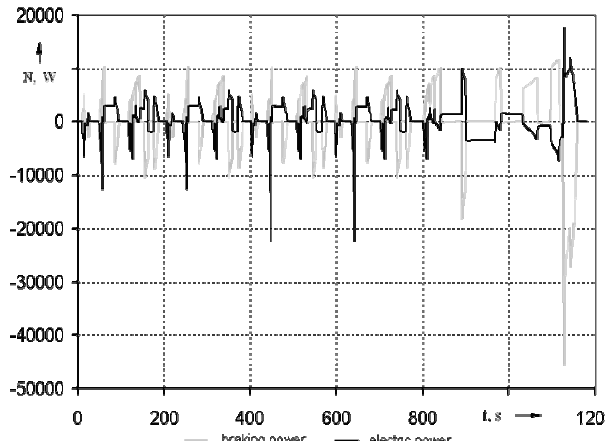
Fig 18. Power characteristics of series hybrid drive, New European driving